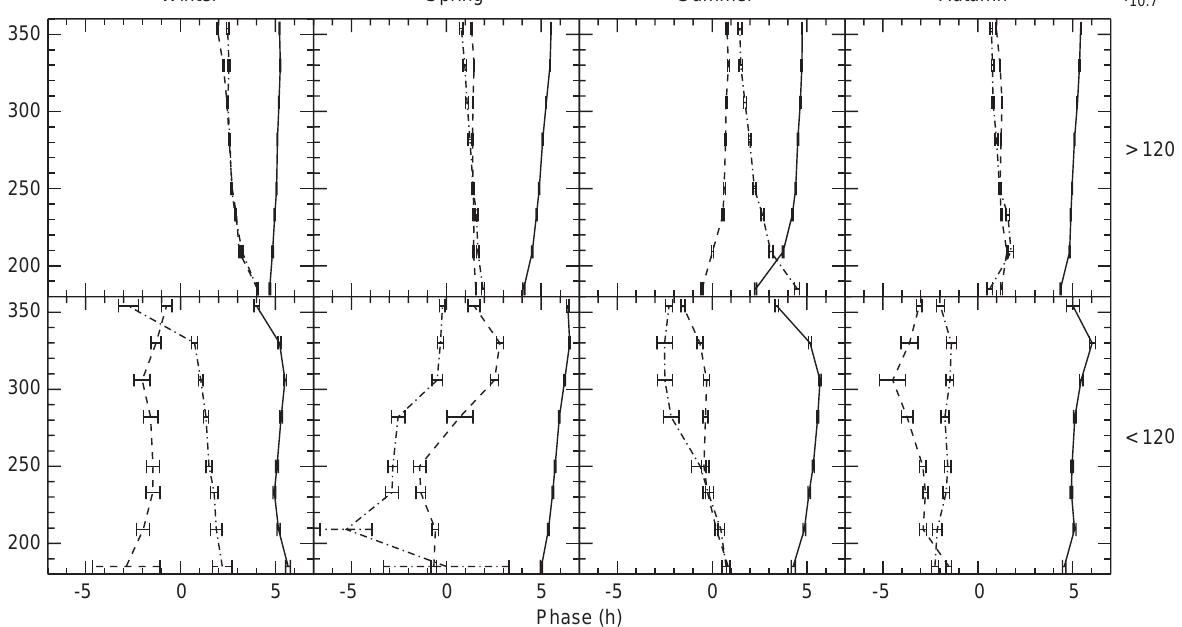
( solid line ), (cid:47) ( dashed line ), and (cid:47) 24 12